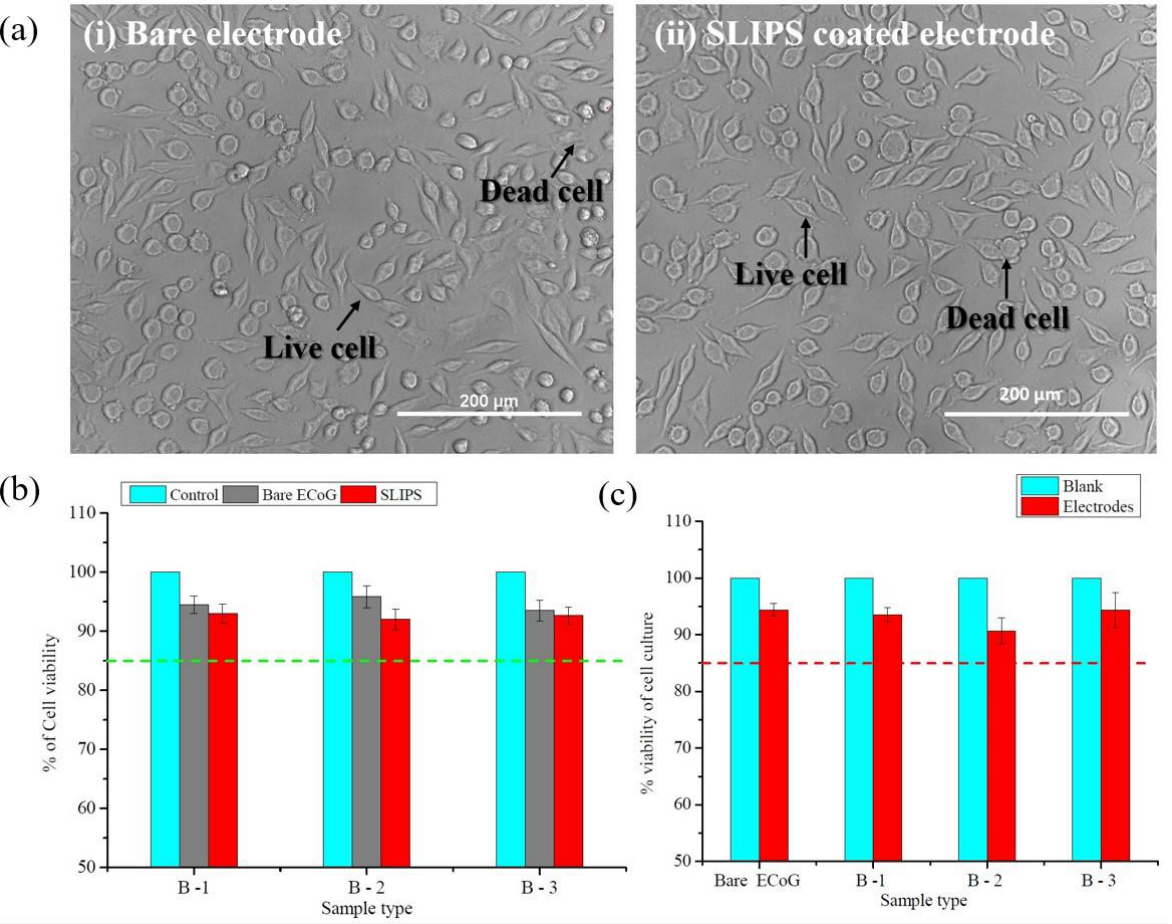
Figure 9. ( a ) Optical microscopy image of cell viability test where live and dead cells are marked by black indicators. ( b ) Cell viability test by cell counting for control, bare, and SLIPS coated electrode, and ( c ) absorbance study of blank, bare ECoG electrode, and various batches (B-1, B-2, and B-3) of SLIPS coated electrodes.